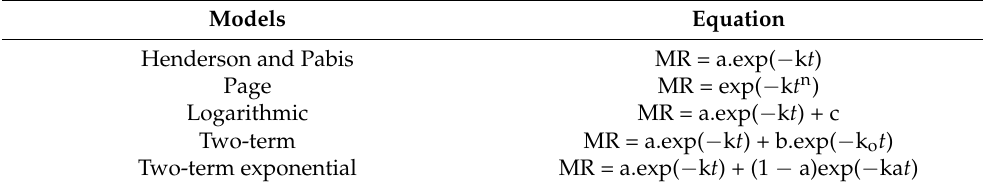
Table 2. Mathematical models used to predict the drying of magenta leaves extract.